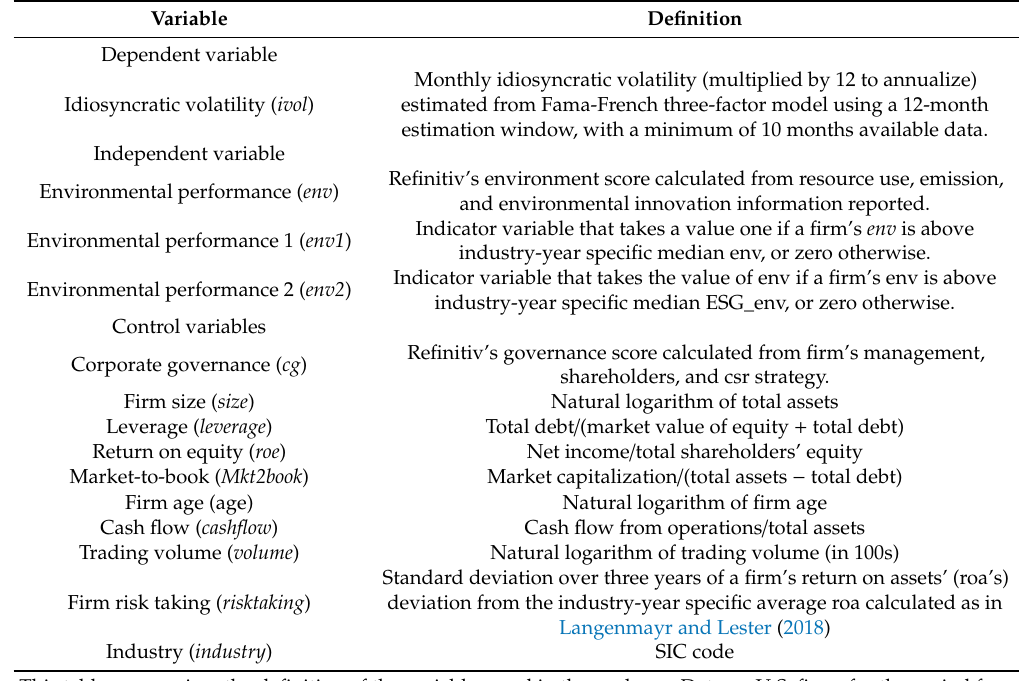
Table A1. Variable